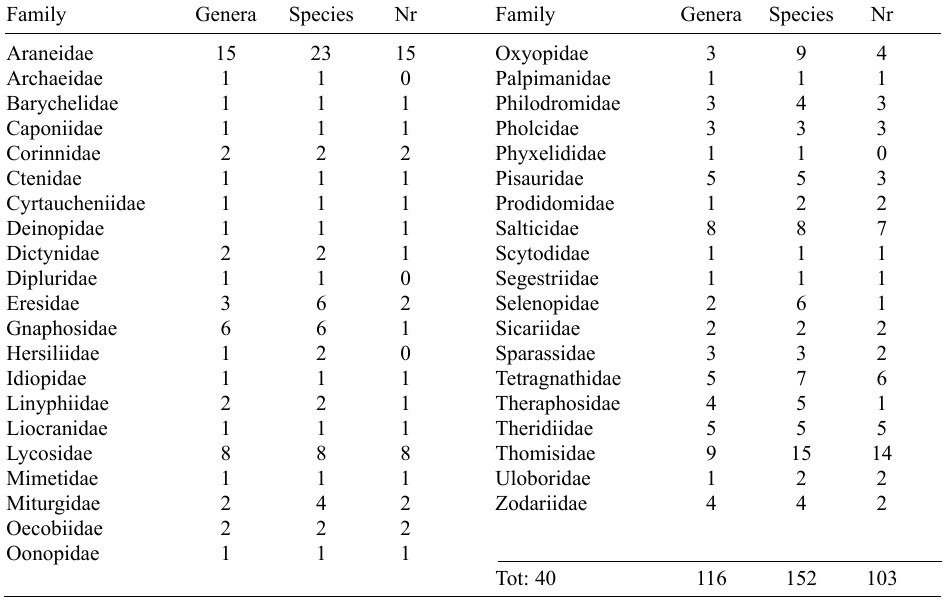
Spider families collected at the Kruger National Park indicating the number of species and genera in each family and the number of species that are new records